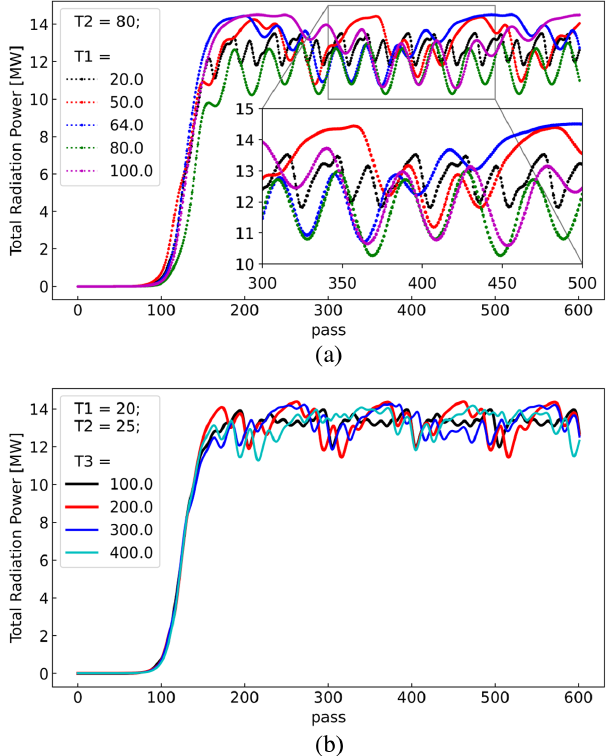
FIG. 8. Evolution of total radiation power per pass for scans conducted (a) for two frequencies with the second frequency component kept fixed with its period at 80 turns, and (b) for three frequencies with two frequencies kept fixed close to each other with their periods corresponding to 20 and 25